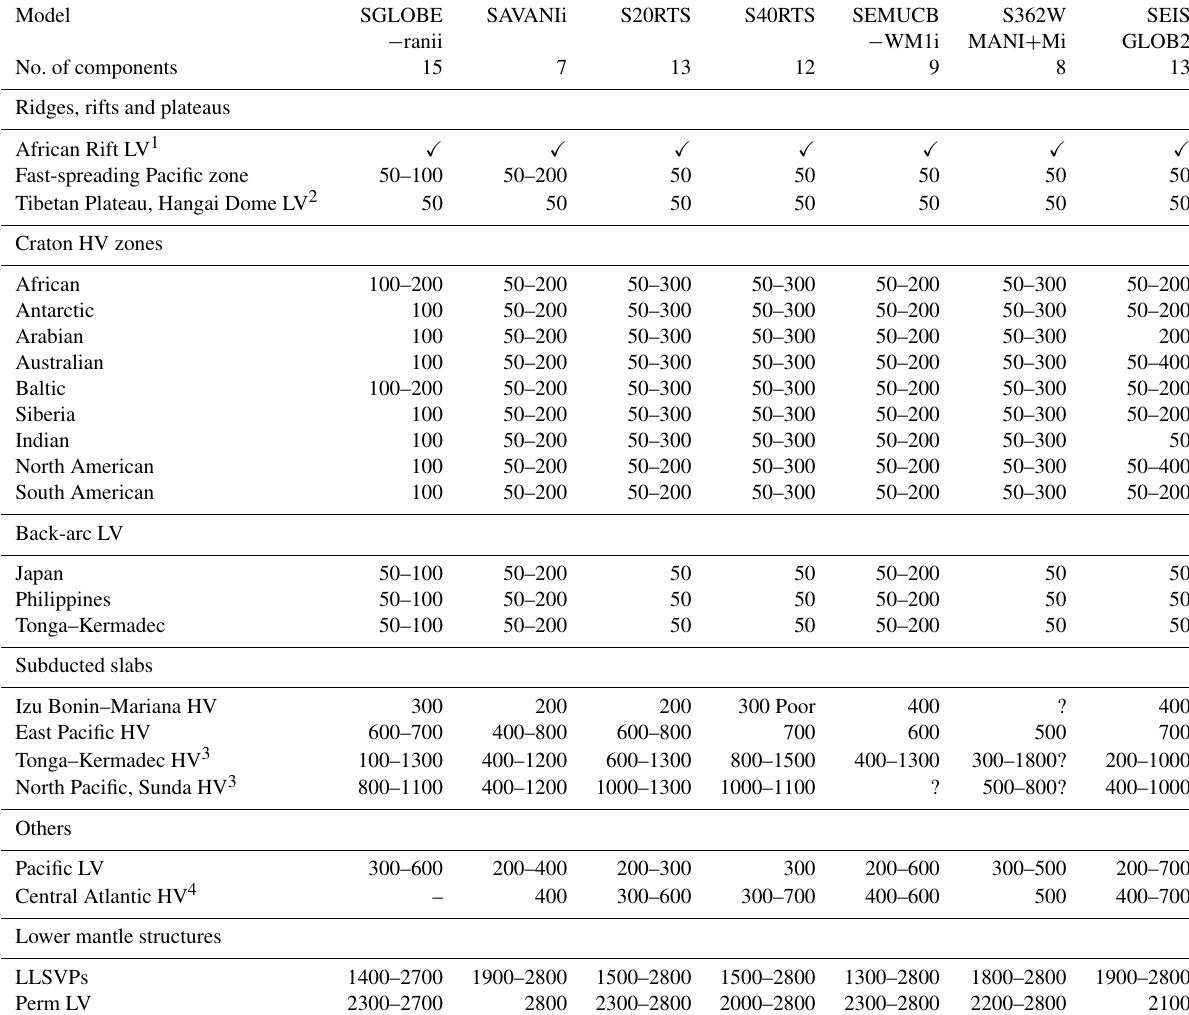
Table 3. Examples of key geophysical patterns recovered in the mantle by the varimax analysis (see Figs. 4 and C1–C6). HV: high-velocity zone, LV: low-velocity